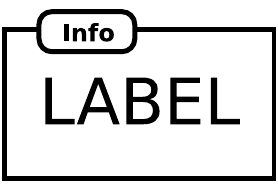
Figure 2.2: The Activity Flow glyph for biological activity .